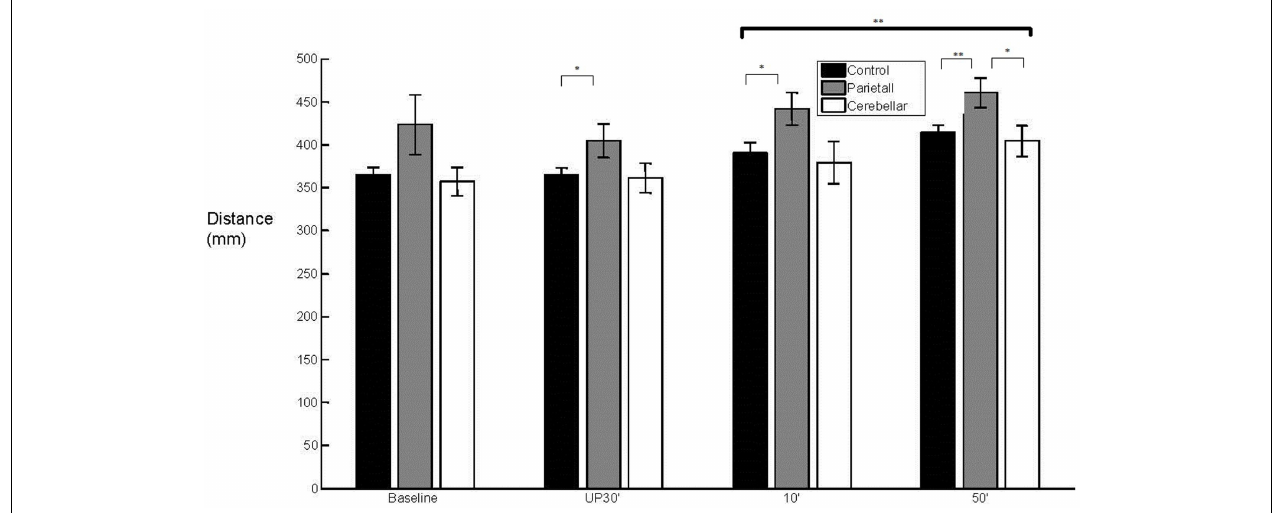
PV and PD and Last PV and MA MA last MA